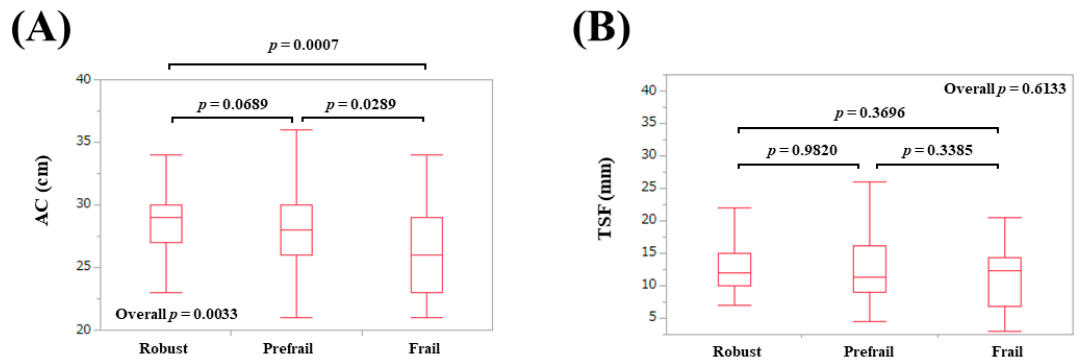
Figure 1. Anthropometry measurements according to frailty status in male participants. ( A ) Arm circumference; ( B ) Triceps skinfold thickness.